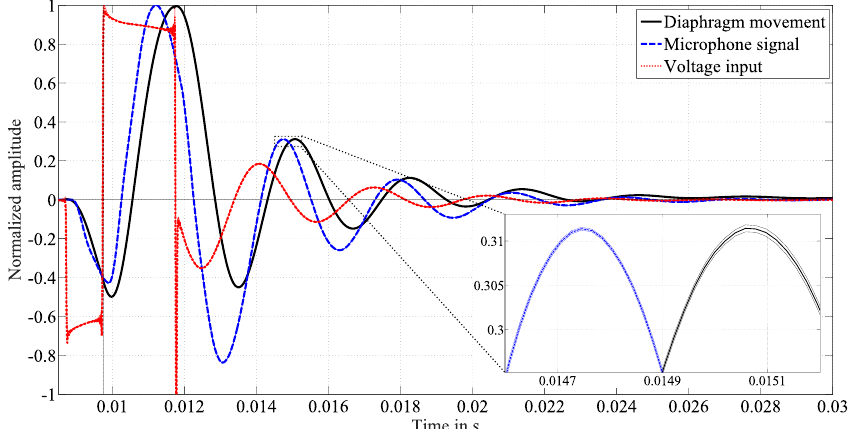
Figure 2. Each of the curves represents the mean of 18 individual impulses that were recorded at one example IOP level. Confidence bounds with the expanded standard uncertainty of the mean (coverage factor k = 2) are drawn by two adjacent lines that surround the mean values (only visible in close-up view). The voltage input causes the speaker to oscillate, i.e., a movement of the diaphragm of the speaker results. The pressure in the closed chamber is monitored with a microphone.